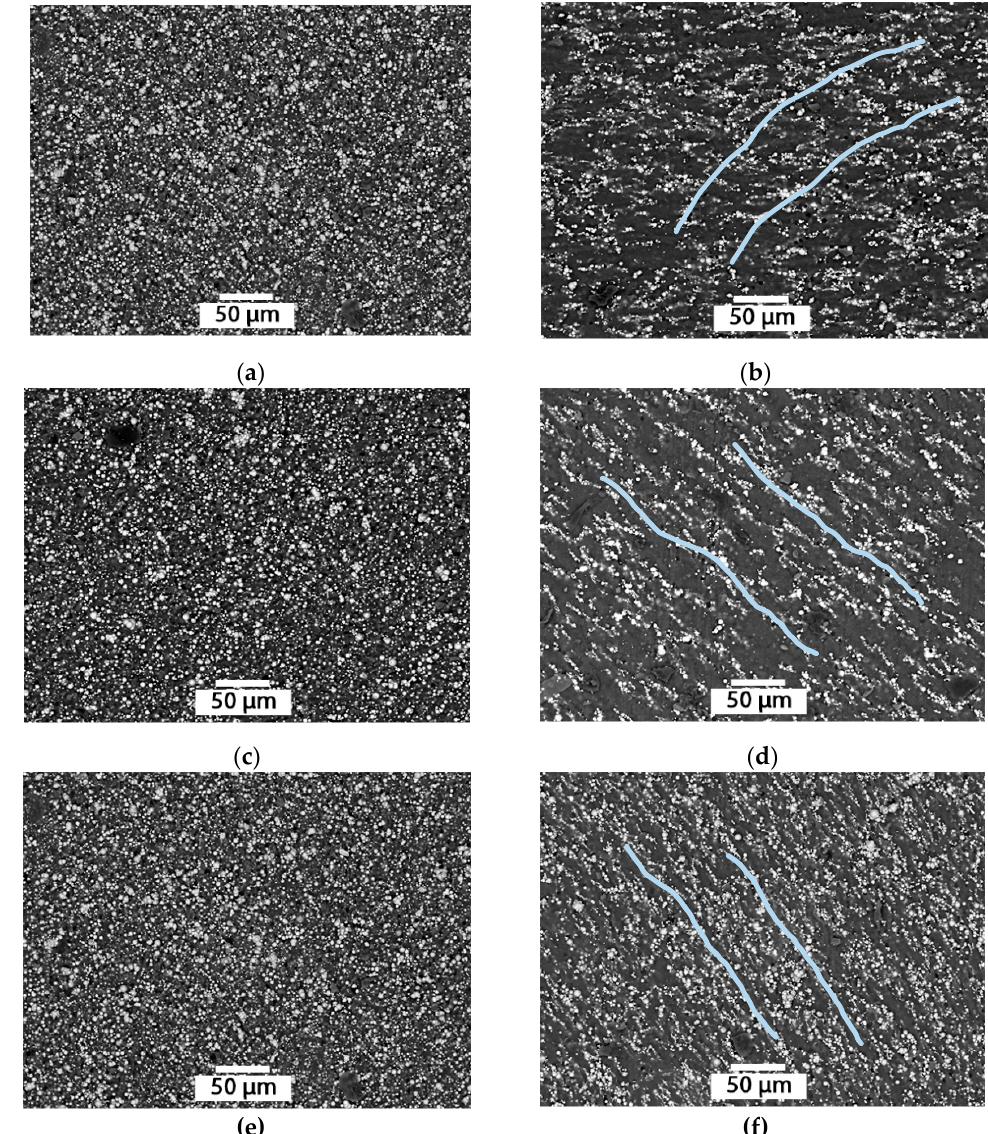
Figure 5. Internal structure of MAE samples: ( a ), ( c ), ( e ) isotropic structure; ( b ), ( d ), (f ) anisotropic structure; 50%, 60%, 70% filling agent content.